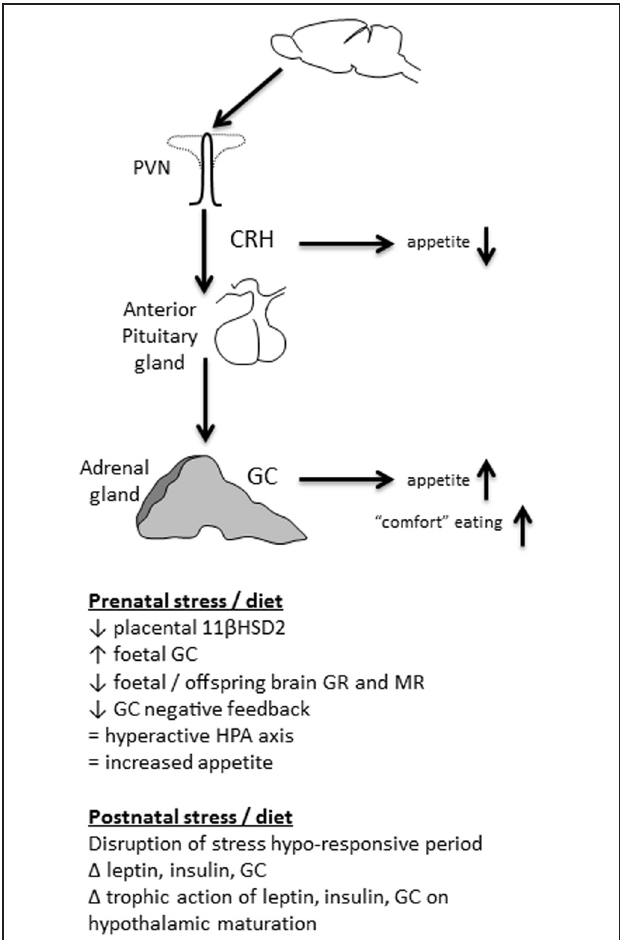
FIGURE 1 | The HPA axis can be programmed by early life stress and diet. When an animal is stressed, medial parvocellular cells in the paraventricular nucleus of the hypothalamus (PVN) are activated. Corticotropin-releasing hormone (CRH) is released into the median eminence, followed by adrenocorticotropic hormone (ACTH) release from the anterior pituitary into the blood stream. ACTH stimulates glucocorticoid (GC) release from the adrenal cortex. Early in the stress response CRH mediates anorexia. As the stress response progresses, GC stimulate appetite, particularly for highly palatable food. Early life events that disrupt HPA axis function can therefore influence feeding behavior